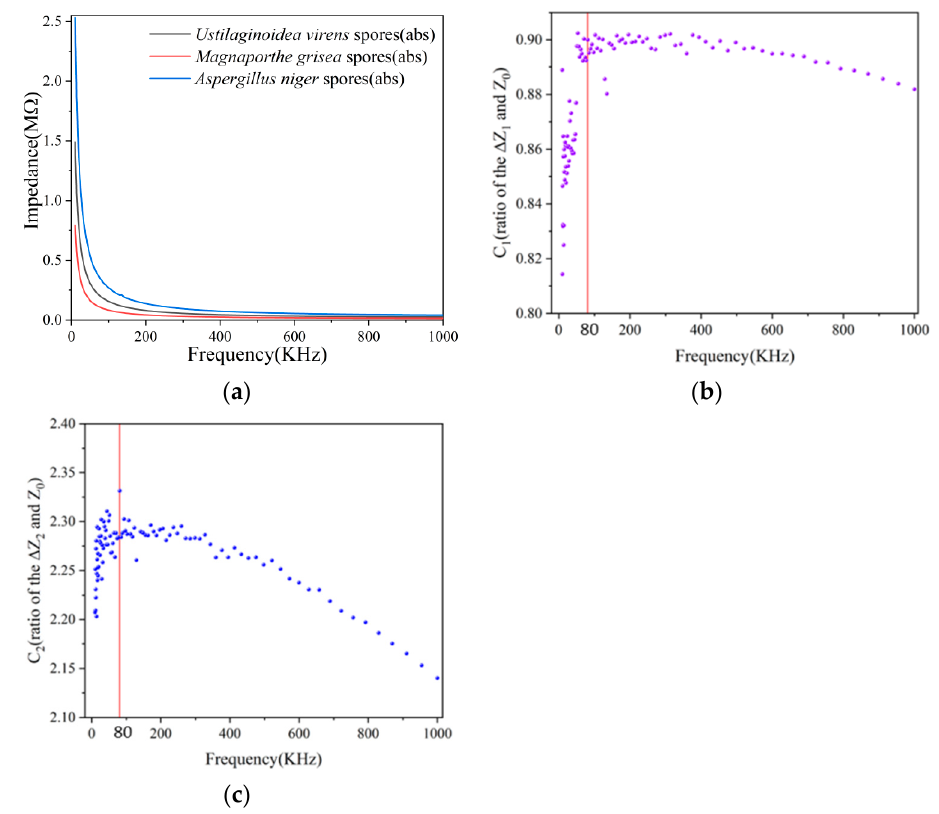
Figure 9. Choose the best measurement frequency, 80 KHz is more suitable ( a ) Impedance changes of three spores at 10–1000 KHz, ( b ) C 1 value at different frequencies, ( c ) C 2 value at different frequencies.